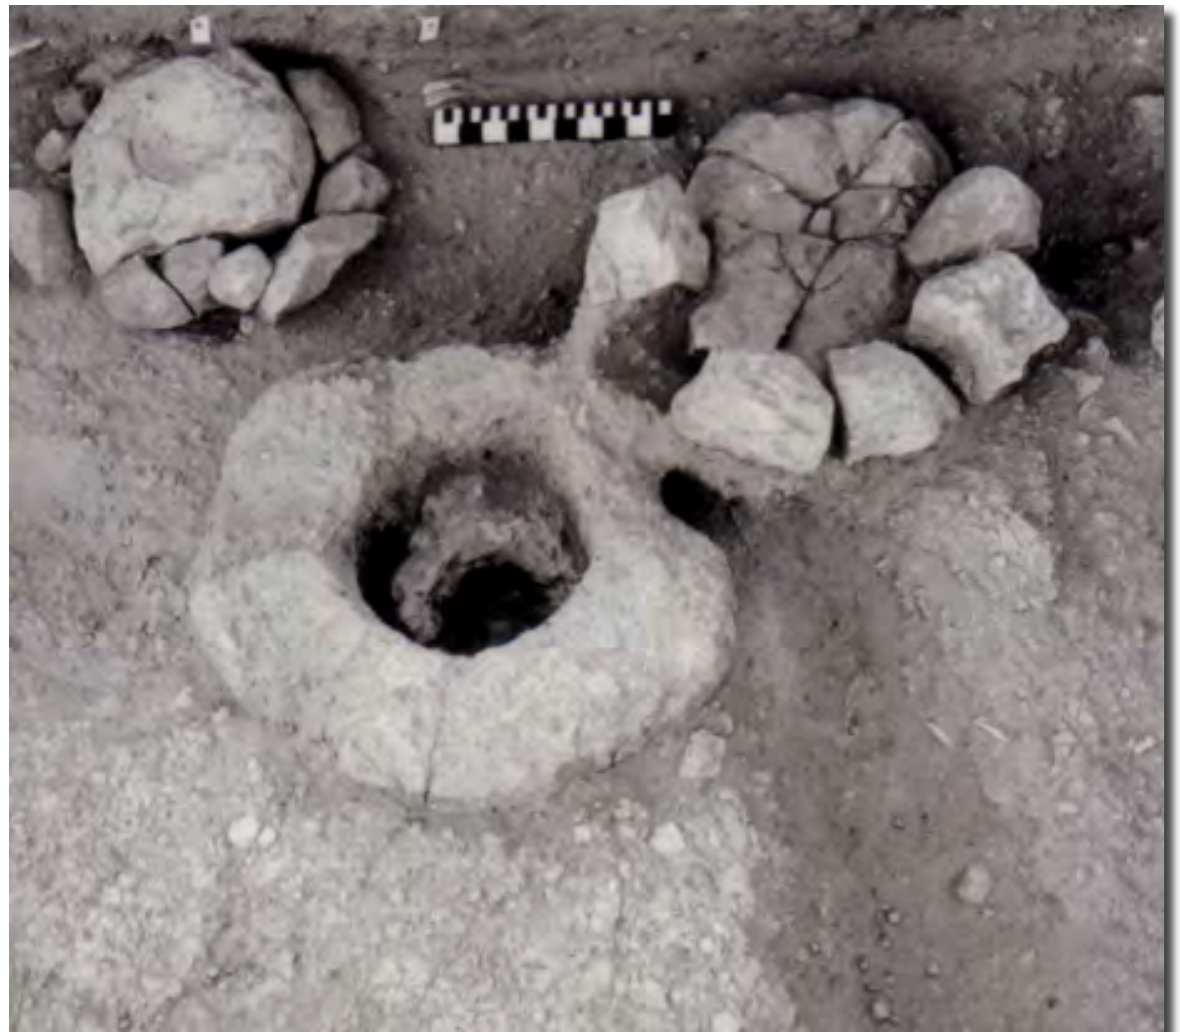
Figure 10. Sunken stone mortar blocks positioned in small, stone lined pits, exposed in Layer 9(i) in Excavation MK1 on Mapungubwe Hill. Note the clay rim surrounding the stamping hollow of the nearest mortar block that is embedded in a gravel floor; the sunken mortar block still mounted in the stone lined pit to the left at the back; and the stone lining including a cracked, flat bottom stone to the right at the back (cf. also Meyer 1998:123, Figure